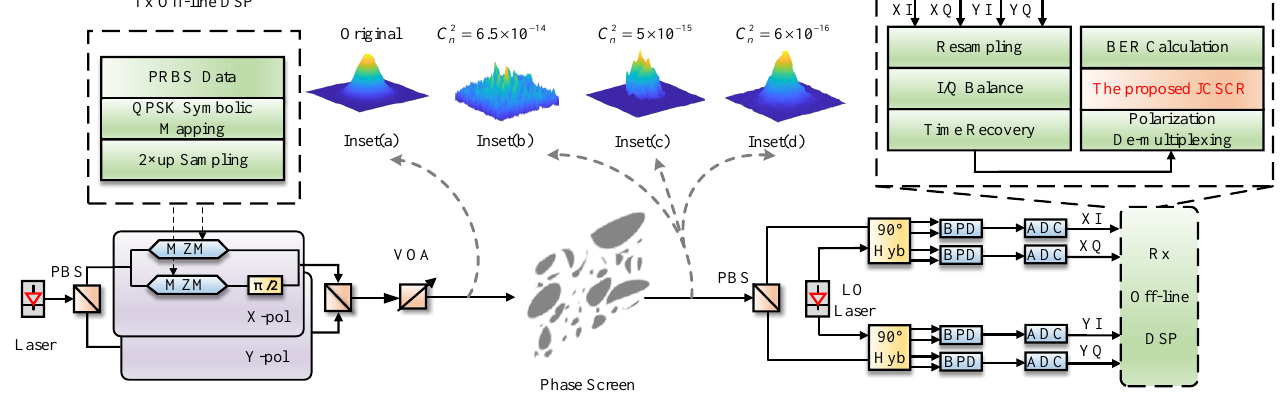
Figure 4. Simulation setup for a 10 Gbps QPSK CFSO transmission system.